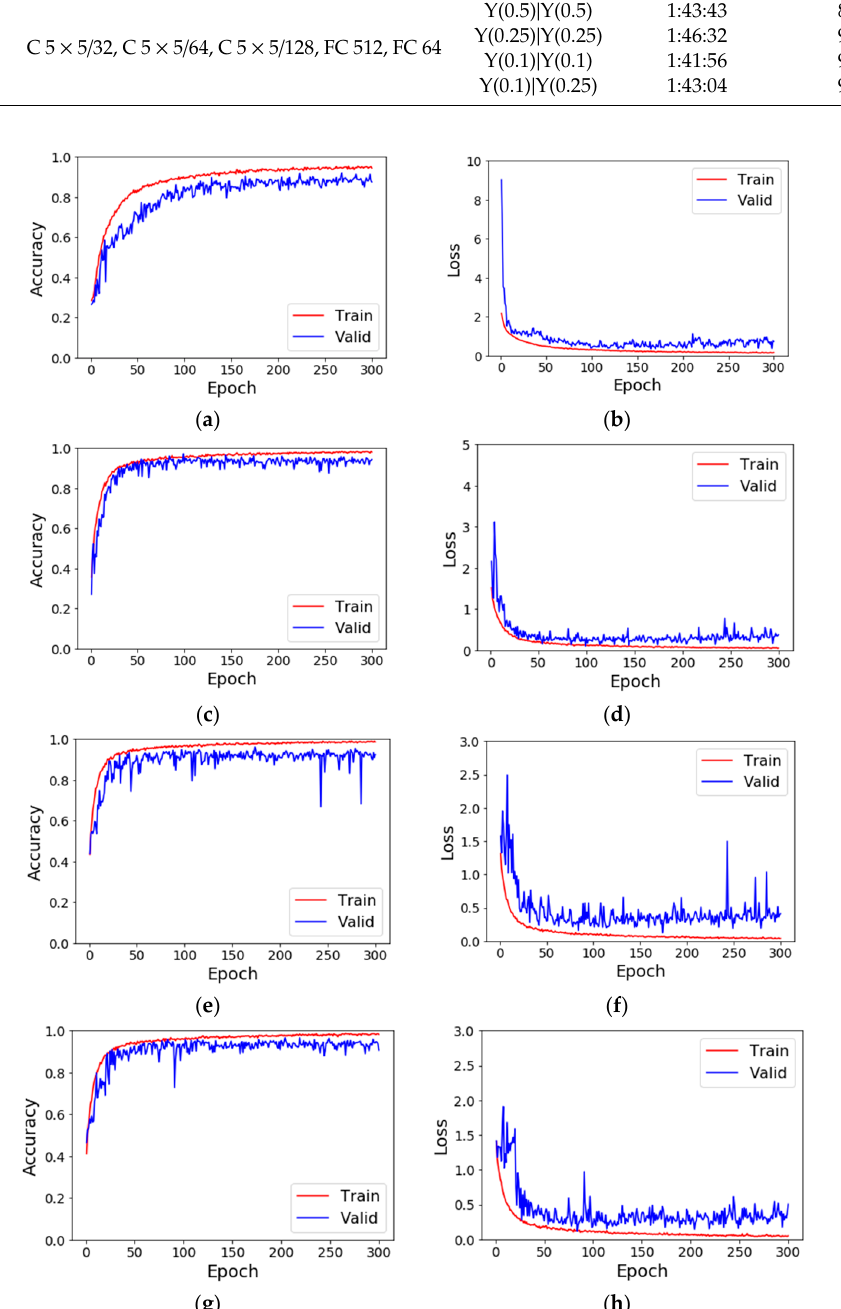
Figure 6. Plots of accuracy and loss for ( a , b ) Model 15, ( c , d ) Model 16, ( e , f ) Model 17 and ( g , h ) Model 18. ( a , c , e ) and ( g ) are accuracy plots and ( b , d , f ) and ( h ) are loss plots. Table 6. Results of fine tuning dropout parameters. The convolutional layers’ parameters are denoted as “C kernel size/number of kernels”. The fully connected layers are denoted as “FC number of hidden units”. Epoch = 300 and learning rate = 1 × 10 − 4 .